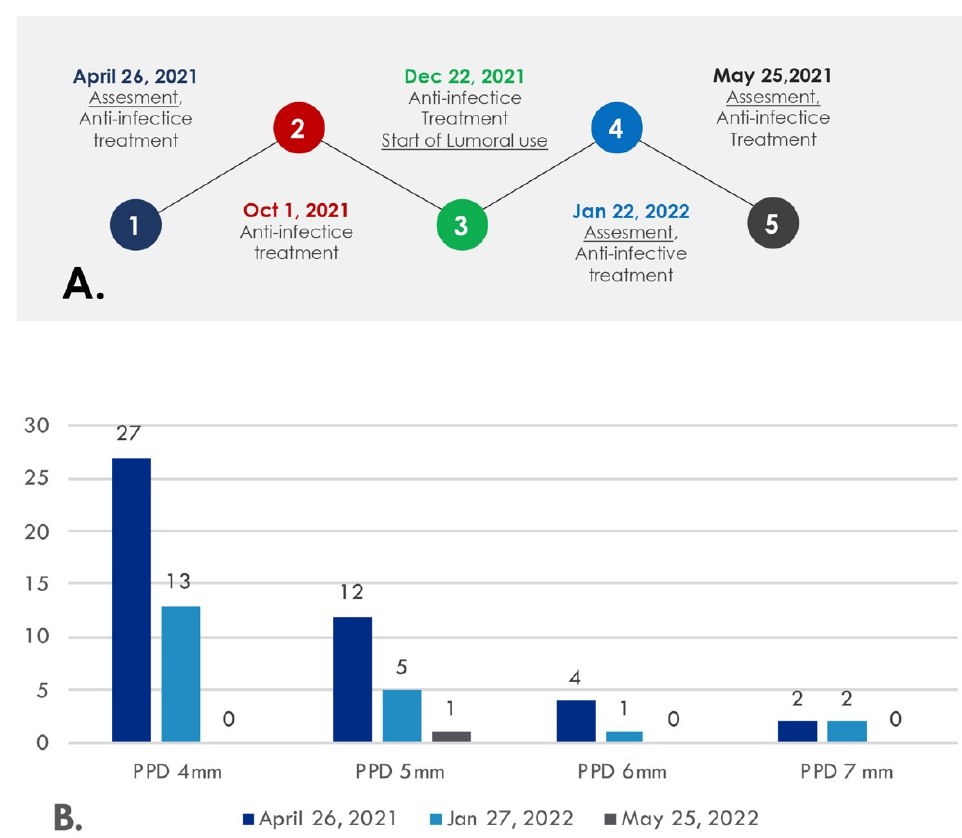
Figure 4. Representation of the clinical situation on 25 May 2022. The white line describes the clinical attachment level and the blue color infected periodontal pockets. The red dots represent a positive result in bleeding on probing.